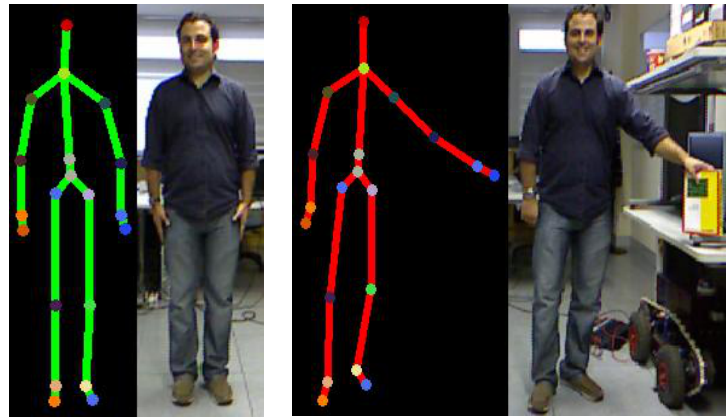
Figure 10. Gesture instantiation and action